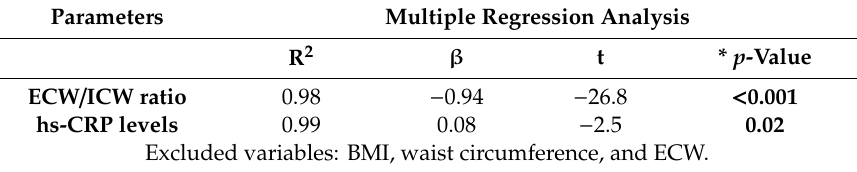
Table 3. Multiple regression analysis models (stepwise method) with the PhA as dependent variable to estimate the predictive value of hs-CRP levels, BMI, waist circumference, and BIA parameters in PWS